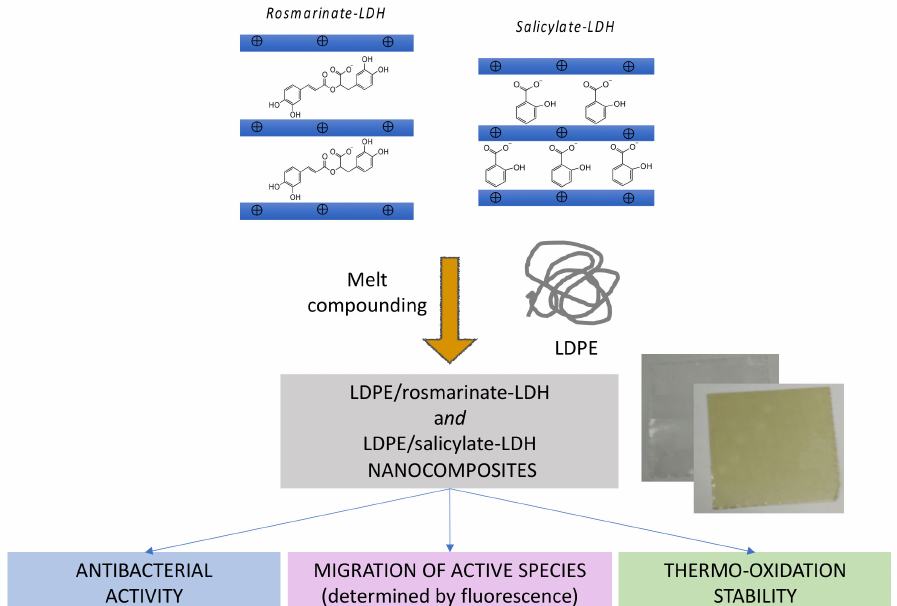
Figure 9. Rosmarinate-LDH and salicylate-LDH, their dispersion into LDPE, and main properties of